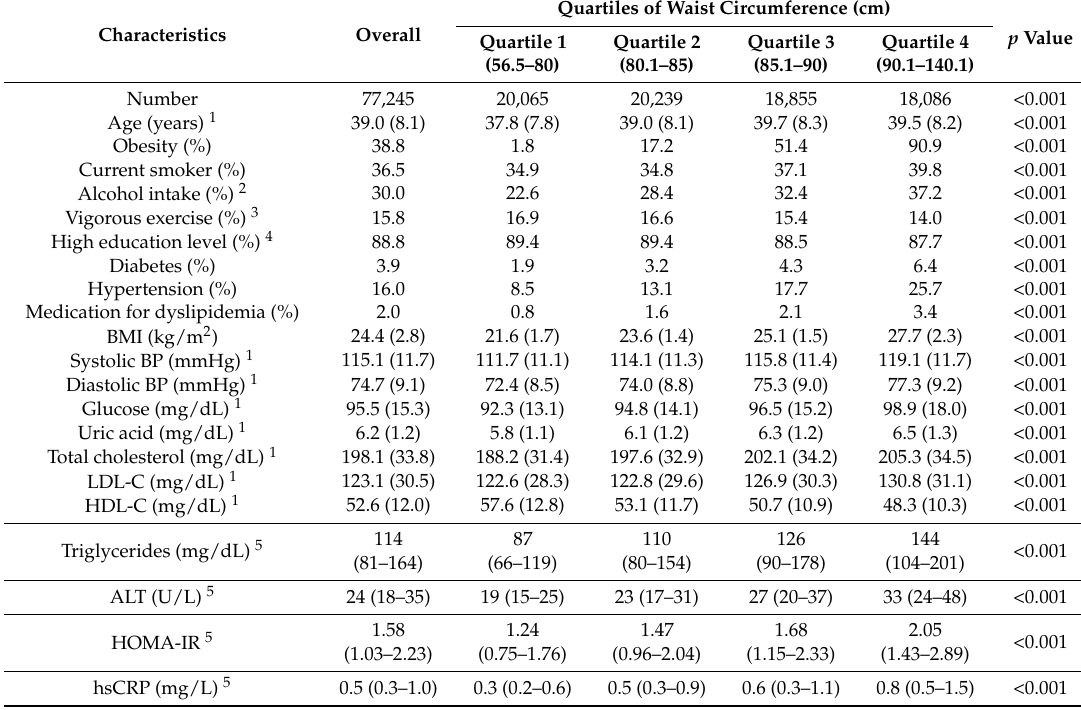
Table 1. Baseline characteristics of study participants by waist circumference among